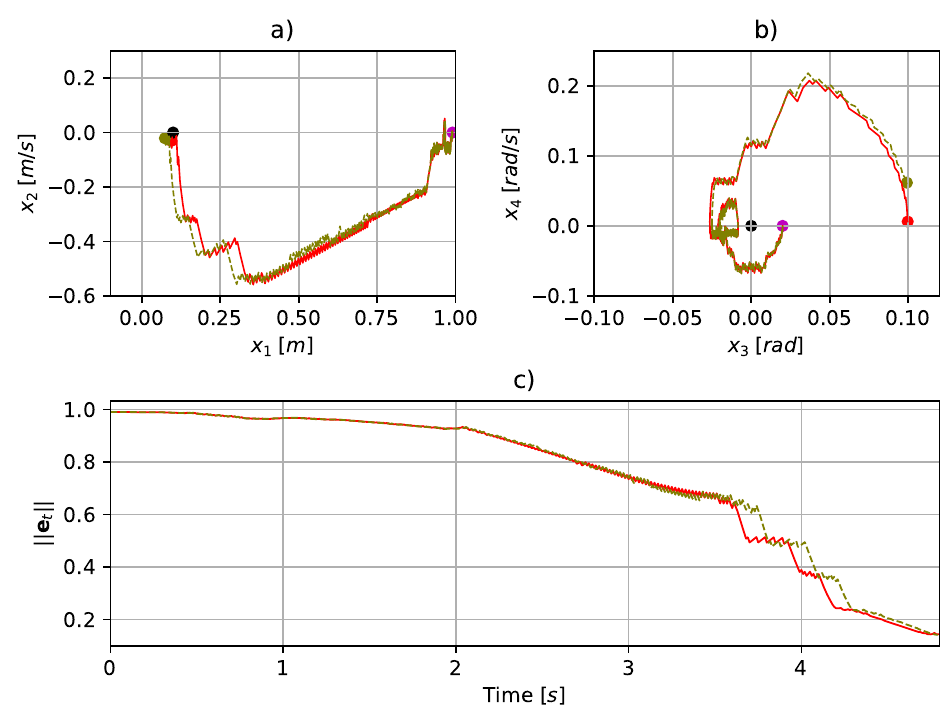
Figure 7. Rocket landing trajectories shown in phase portraits (( a ) height position versus its velocity, and ( b ) angular position versus its velocity) using the proposed variable box method without disturbances ( red ) and subject to a disturbance η ( olive ). The purple and black dots represent the t initial and desired conditions, respectively. Remarkably, L 2 norm of errors ( c ) yields similar plots, showing trajectories are learned for both cases, despite the strong disturbance ( olive ) at the expense of a slight (admissible) final